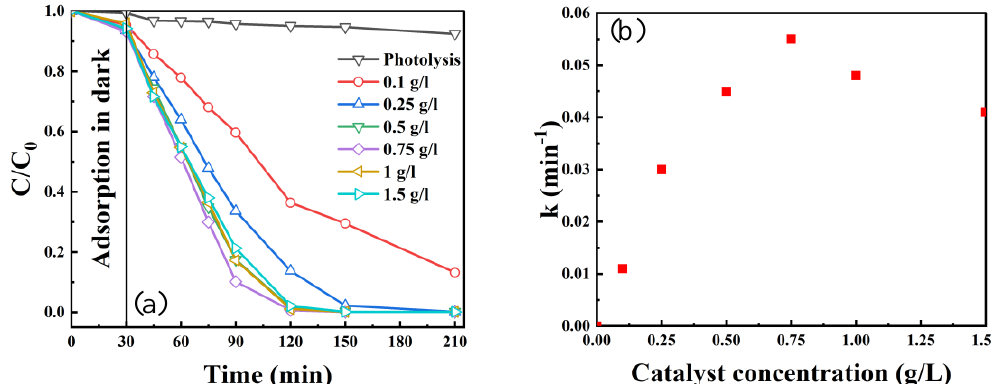
Figure 7. ( a ) Photodegradation curves of phenol concentration ( b ) reaction rate constant as a function of the catalyst concentration; C 0 = 20 ppm, airflow = 50 mL/min, pH = natural, light source = LEDs, Catalyst = exfoliated g-C 3 N 4 .